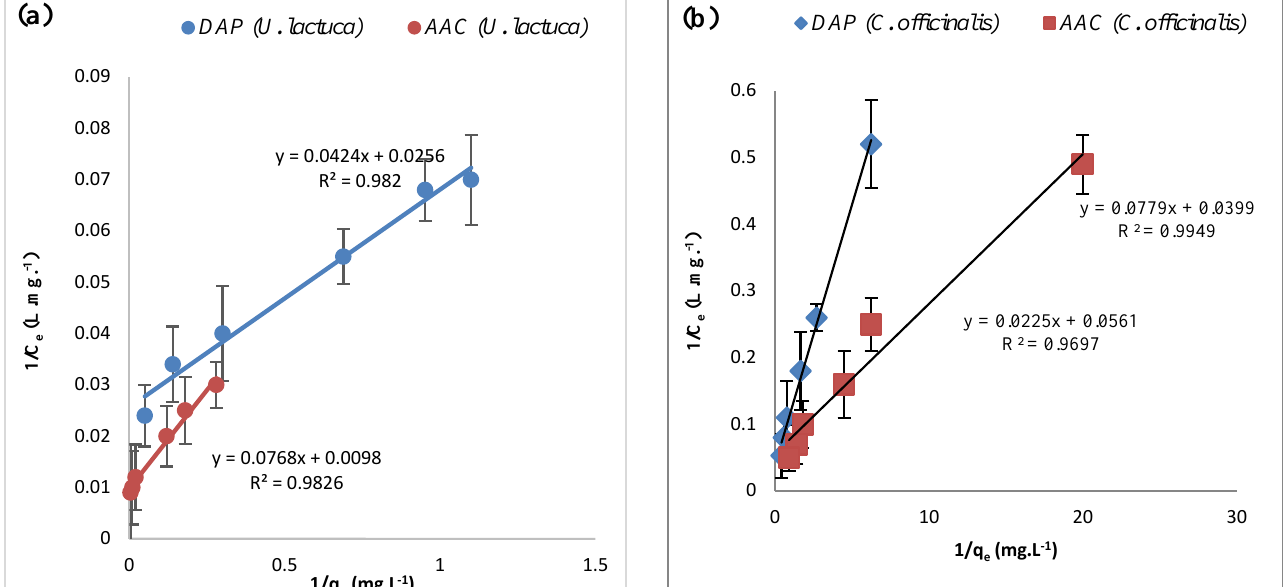
Fig. 7 Figure 6. Plot of ln k d versus 1/T for adsorption of Zn +2 and Fe +3 ions (50 mg.L − 1 ) on DAP and AAC of both U. lactuca and C. officinalis (1g.L − 1 ). Each data point represents the mean ± SD.